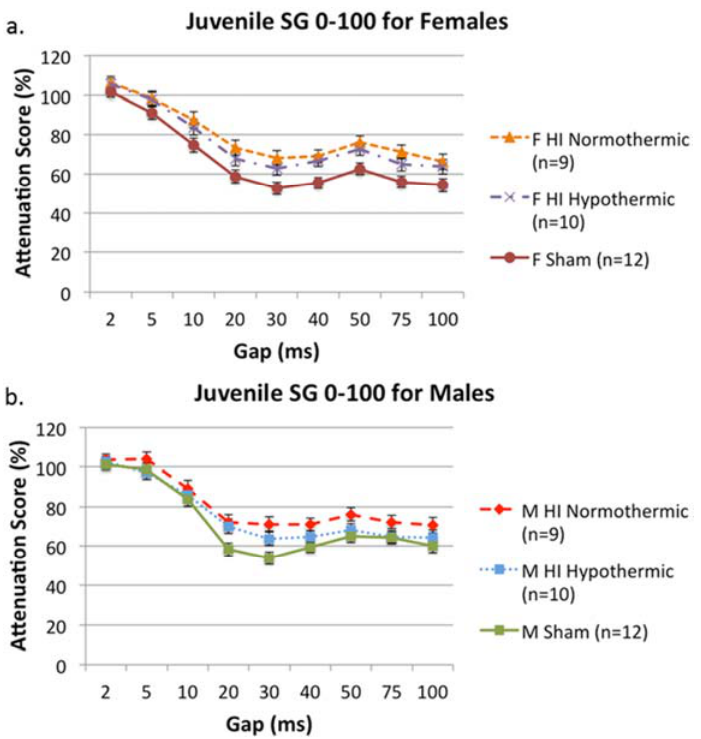
Figure 2. ( a ) A 5 (Day) × 9 (Gap) × 3 (Treatment) repeated measures ANOVA